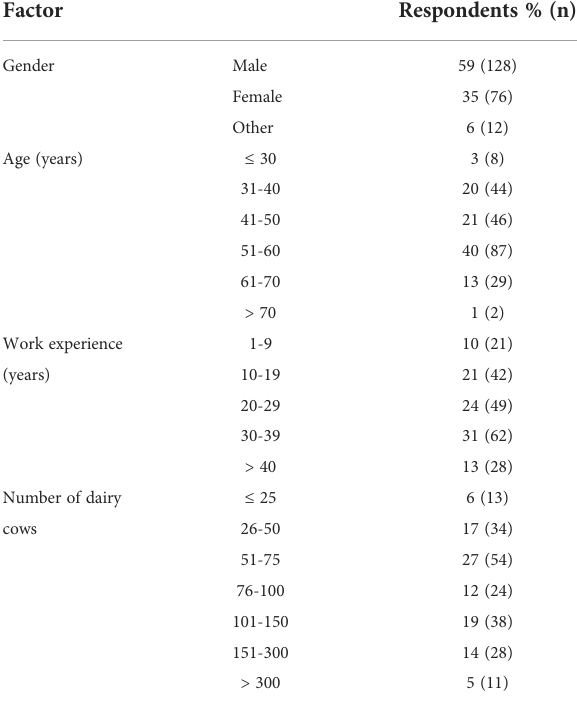
TABLE 1 Descriptive information on